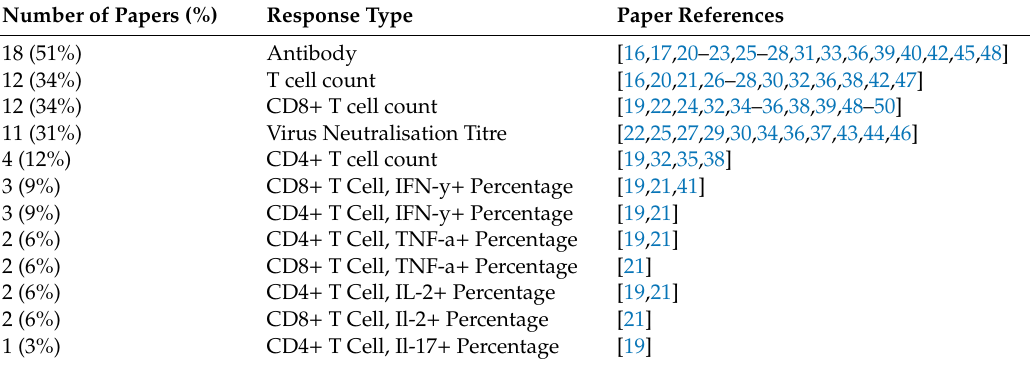
Table 3. The number and percentage of papers that included dose-response data for each immunological response type.